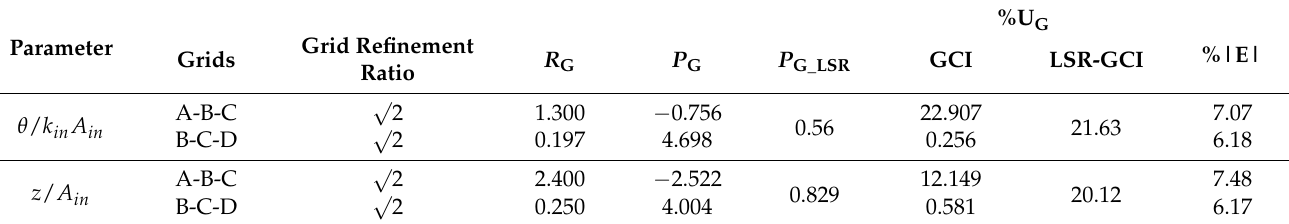
Table 5. Grid uncertainty